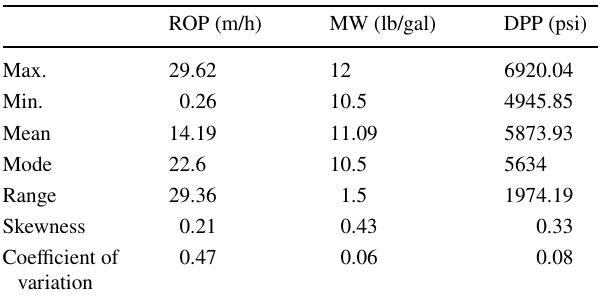
Table 2 Statistics analysis of the input parameters